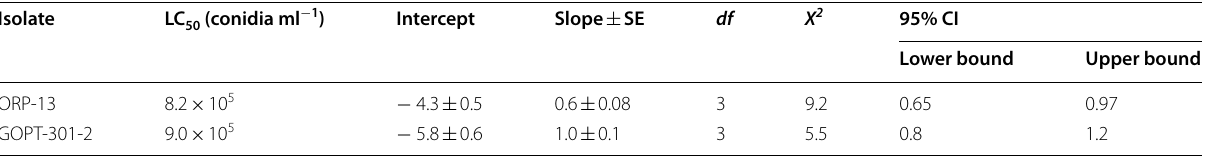
X 2 Chi-Square test, df Degree of freedom, CI Confidence interval